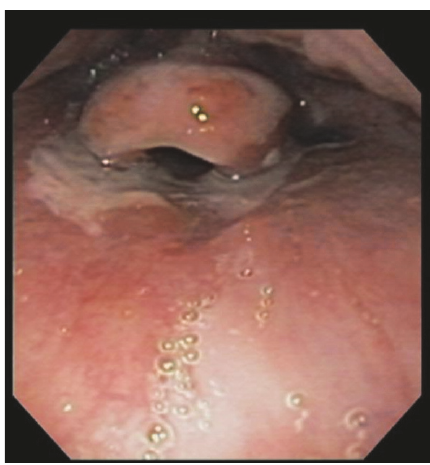
Figure 2: Edema and blisters on